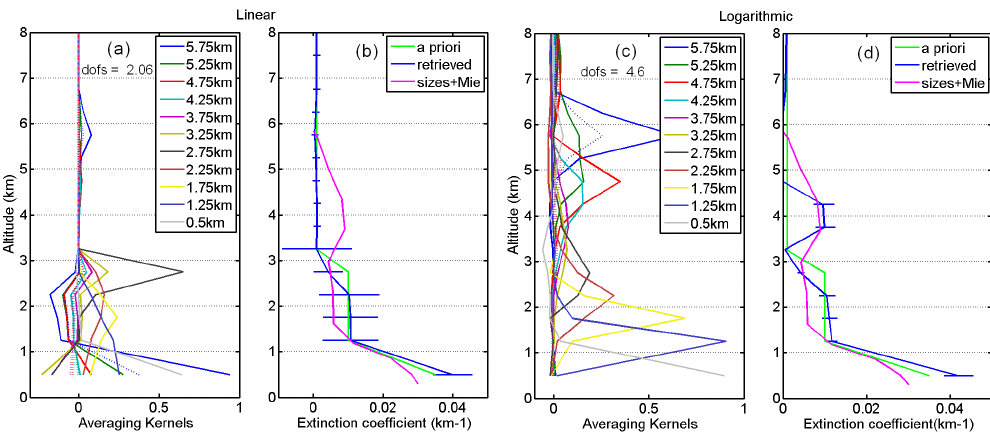
Fig. 9. Influence of the stratosphere on NO 2 tropospheric observations. Measured NO 2 DSCD during the sounding (blue) are compared with simulations (green) neglecting the stratosphere (left) or not (right). The latter agrees better with the observations.